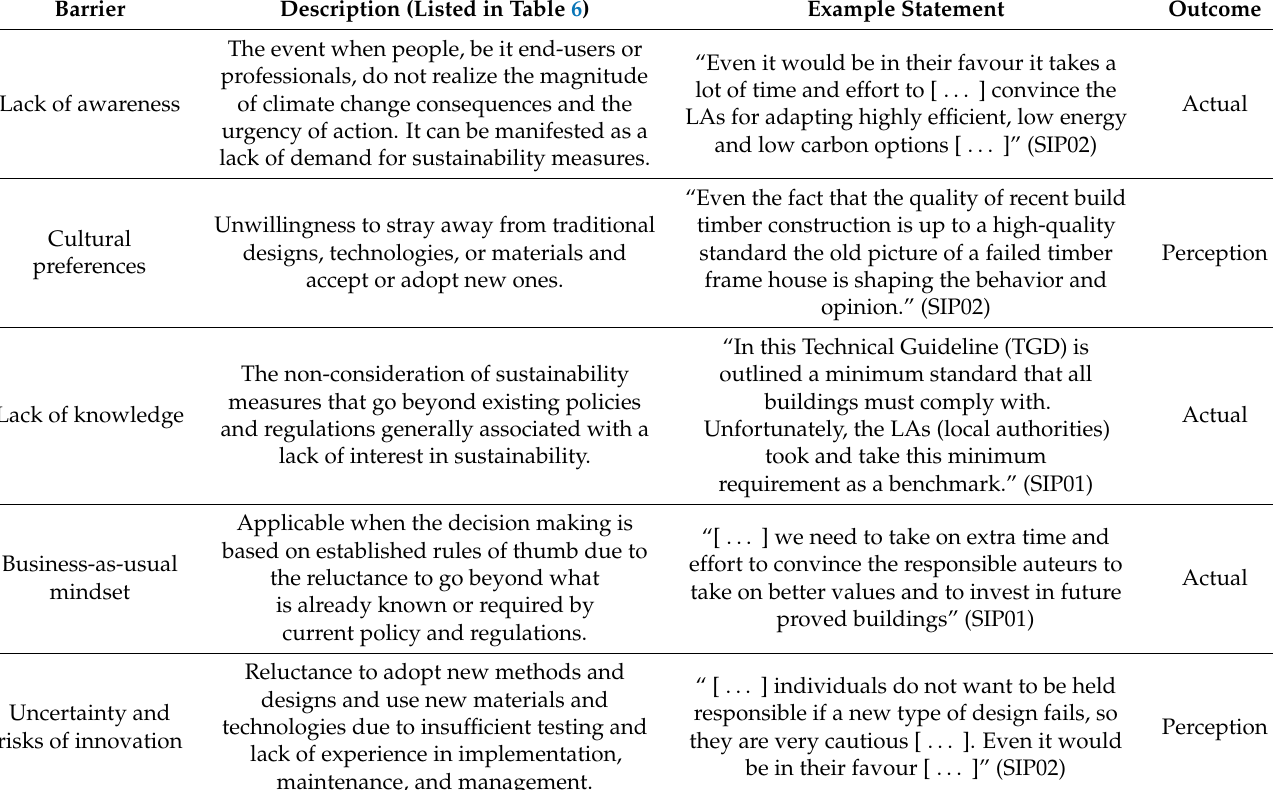
Table 8. Codebook for the analysis of semi-structured interview